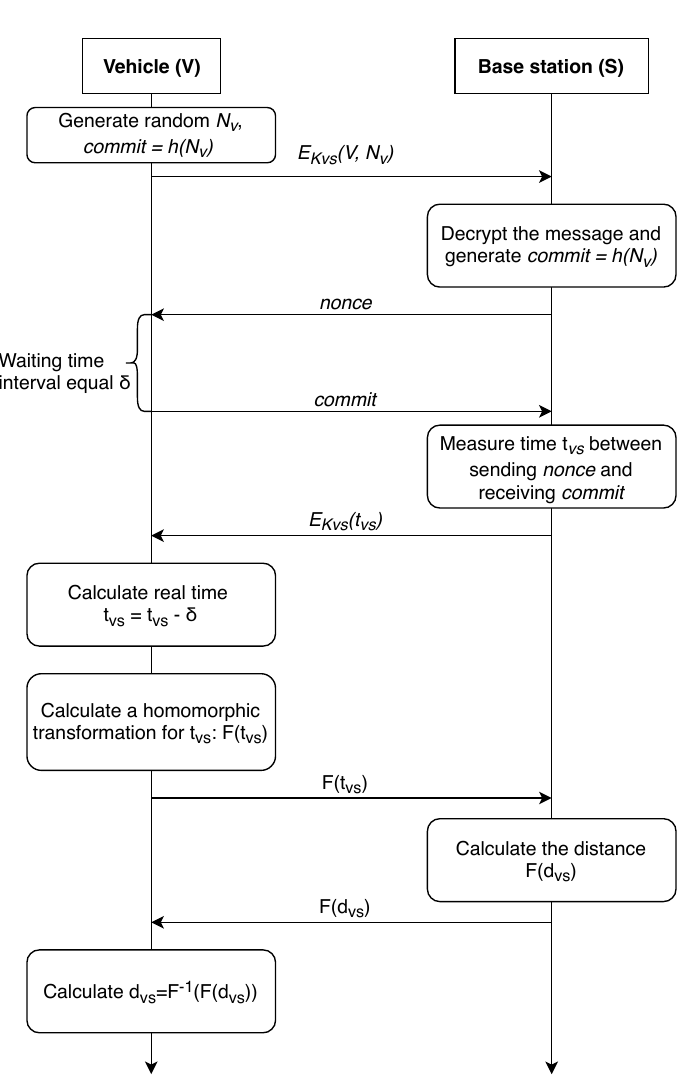
Figure 8. A distance-bounding P-AF-BS protocol with the property of anonymity (calculations are made on the base station